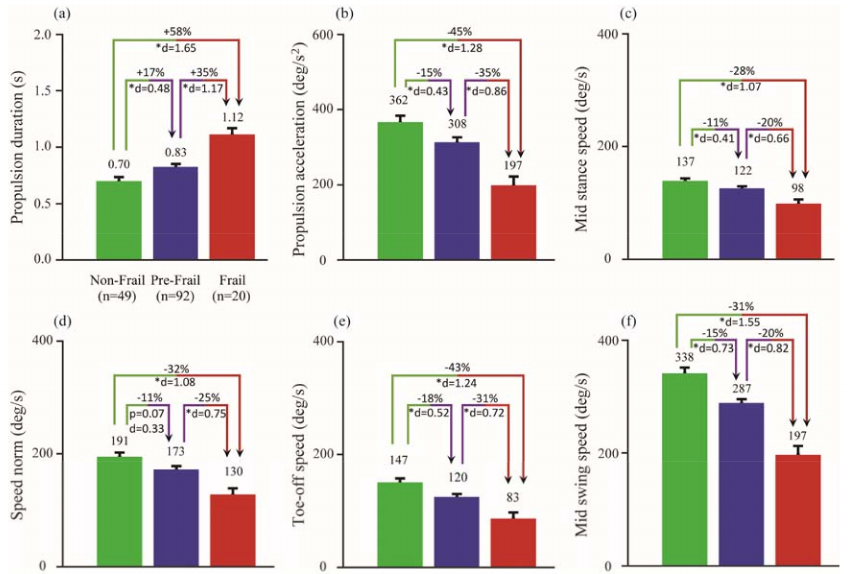
Figure 3. Result of univariate analysis of covariance for the six gait parameters ( a – f ) adjusting for gender, age, and BMI for the right sensor. * indicates statistical significance with alpha = 0.050. Percentage differences and Cohen’s effect size (d) were also calculated in each pairwise